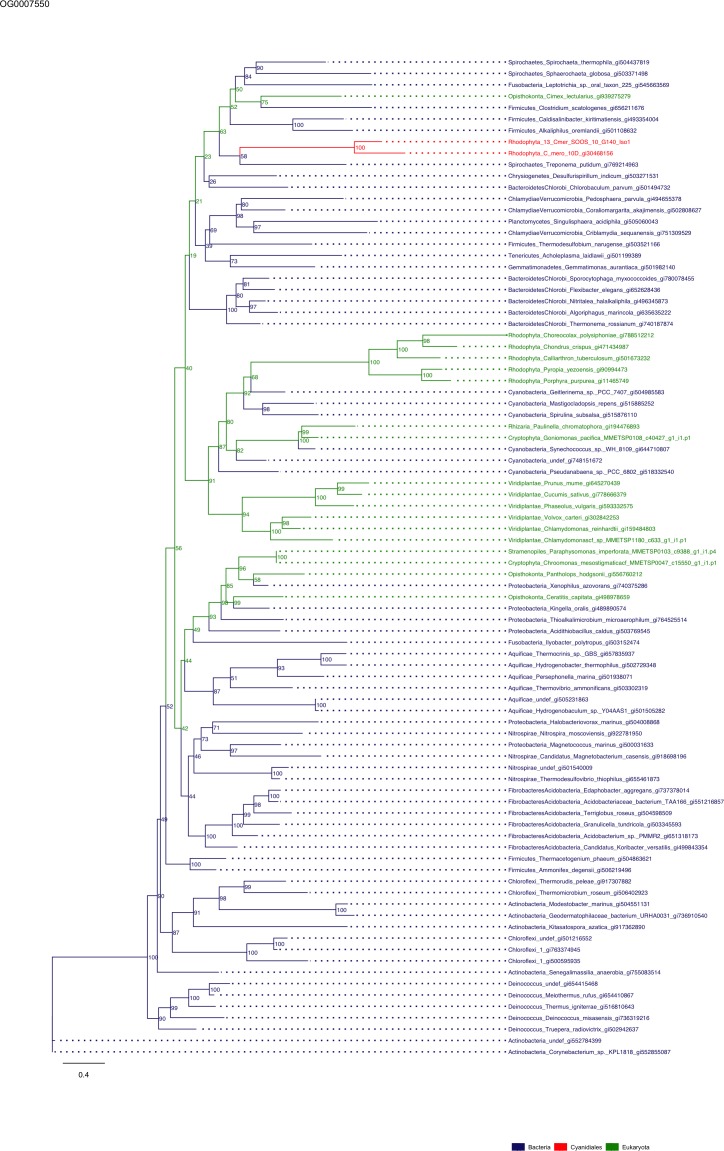
Sequence tree of orthogroup OG0007550.The tree is based on amino acid sequences. Archaea (yellow), Bacteria (blue), Cyanidiales (red), Eukaryotes including other red algae (green). Branches containing Cyanidiales sequences are highlited in red.